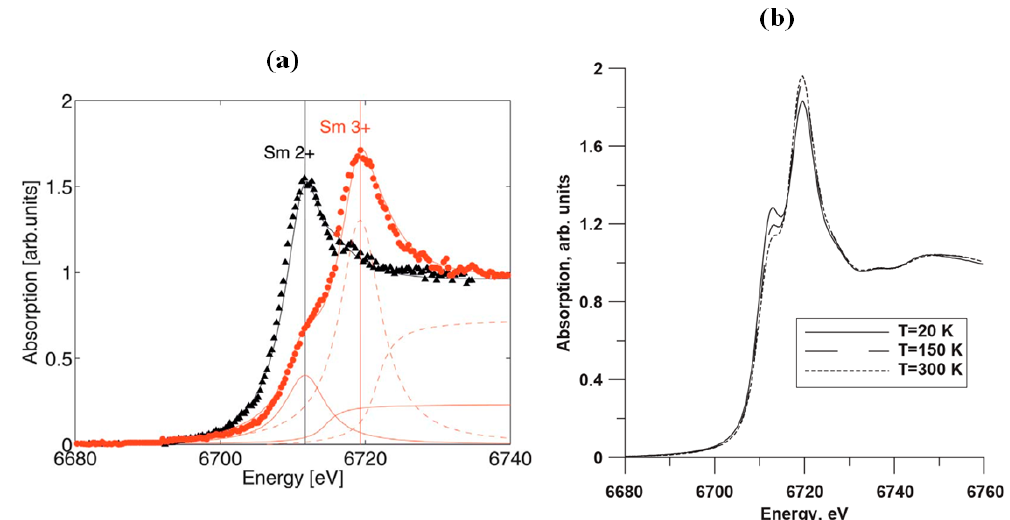
Figure 5. ( a ) X-ray absorption spectra at 4.5 K of the Sm 2+ L3 transition of SmS. Black triangles correspond to a pressure of 0 GPa, while the red dots are upon application of 1.85 GPa; ( b ) XANES spectra of Sm 0.55 Y 0.45 S thin films at several temperatures, without application of pressure. (Reprinted with permission from [26] and [45], respectively.)